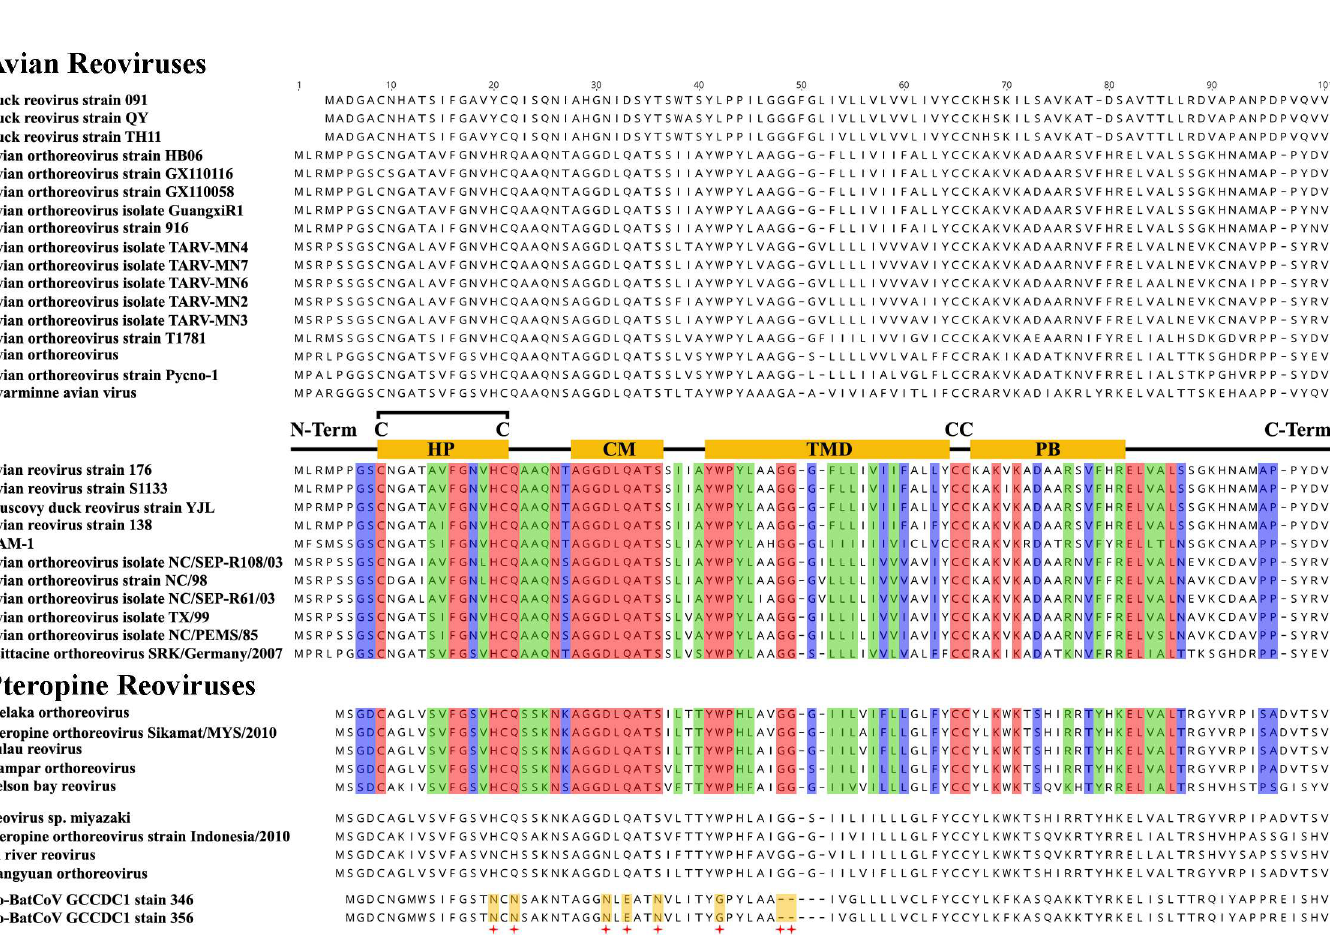
Fig 7. Comparison of the p10 proteinof Ro-BatCoV GCCDC1withthoseof avian and bat originorthoreovirus. The absolutely, highly, moderately and non-conservedamino acids of p10 proteinsas definedpreviously [26],are illustratedwith red,blue, green and black colors, respectively. The motifsand domainsin the p10 moleculeare represented as previously reported[26].Motifspresentin the ectodomain(HP, hydrophobic patch; CM, conservedmotif), endodomain (PB, polybasic) and the central transmembranedomain(TMD)are depictedwith yellow rectangles.The four conservedcysteineresidues(C) are shown. The two cysteines in the ectodomain form an intra-moleculardisulfidebond. Comparison of the p10 proteinof Ro-BatCoV GCCDC1with those of avian and bat originorthoreoviruses,the 8 differentaminoacids (includinga 2 amino acid deletion)in the 28 absolutely conservedamino acids are symbolized with red